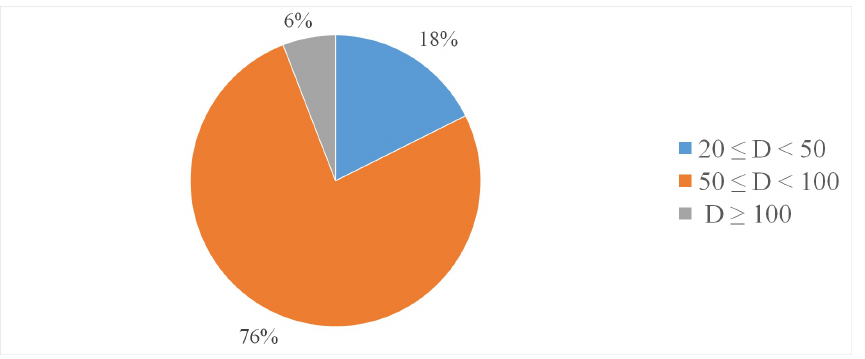
Figure 7. Category #3: pipe diameter. Percentages of the papers for the three diameter